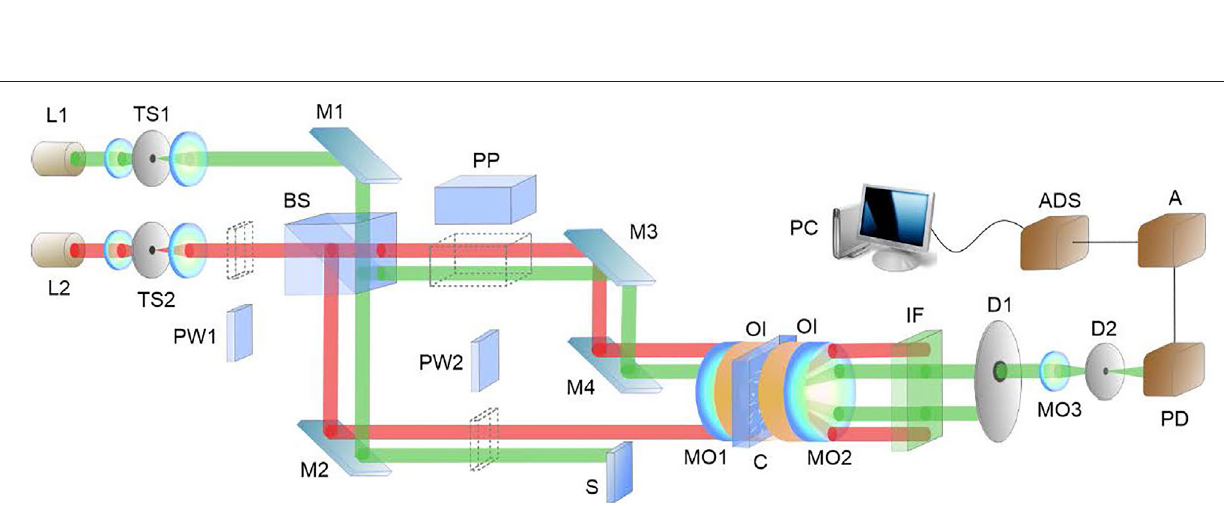
Frontiers in Physics |